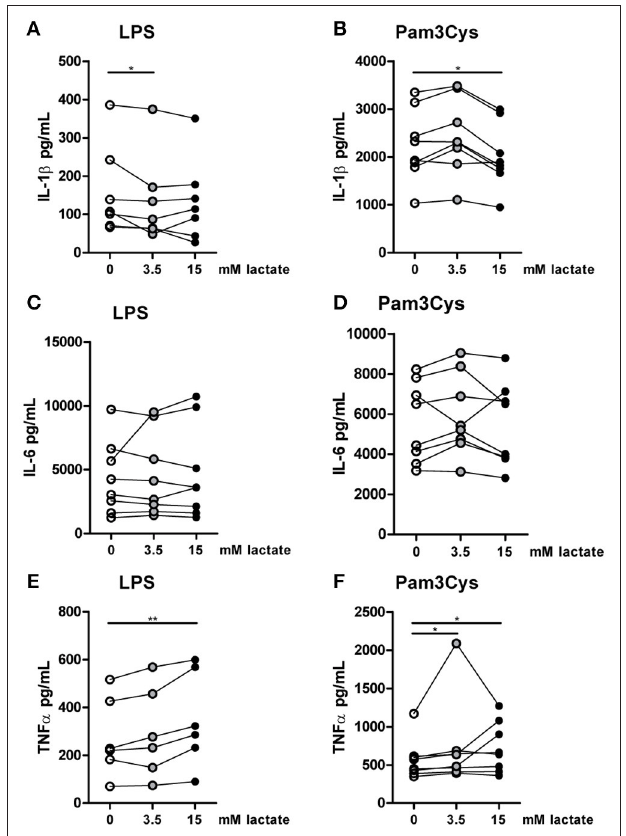
FIGURE 8 | In vitro , lactate reduces IL-1 β production of monocytes. Cytokine production of CD14 + monocytes from healthy individuals. Monocytes were pretreated with lactate for 1h before LPS (A,C,E) or Pam3Cys (B,D,F) was added for 24h. (A–F) n = 6–8. * p < 0.05, ** p < 0.01, Friedman test with post-hoc Dunn’s test.